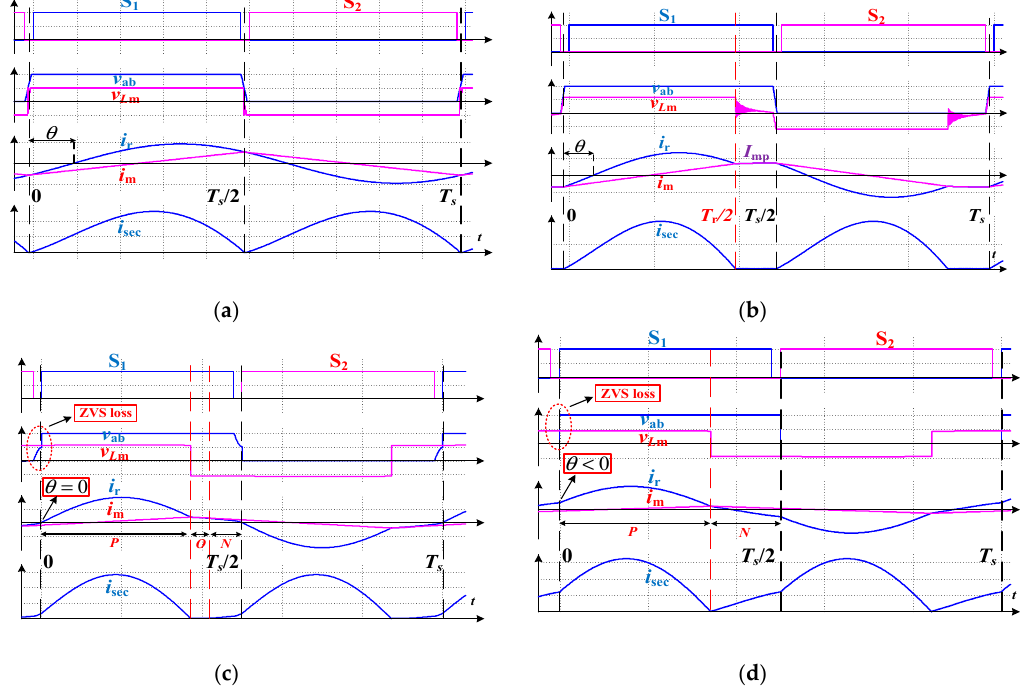
Figure 2. Operating mode division of LLC ( f ≤ 1): ( a ) P mode( f = 1); ( b ) PO mode; ( c ) PON mode; ( d ) PN mode.